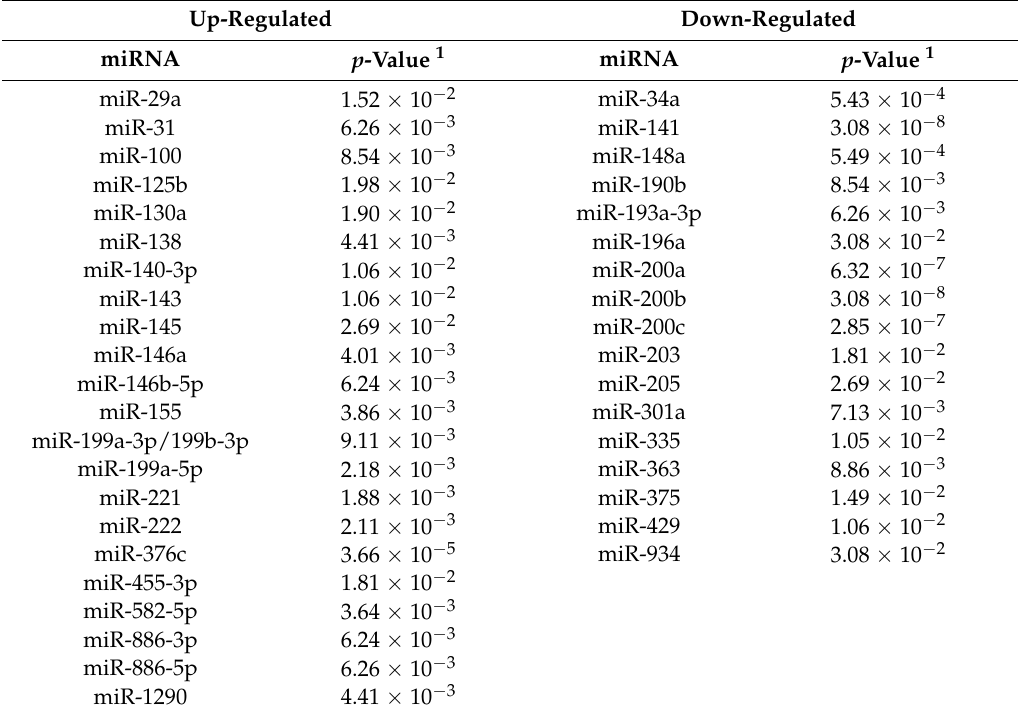
Table 1. The 39 significantly deregulated microRNAs (miRNAs) in triple-negative/mesenchymal-like breast cancer cell lines.